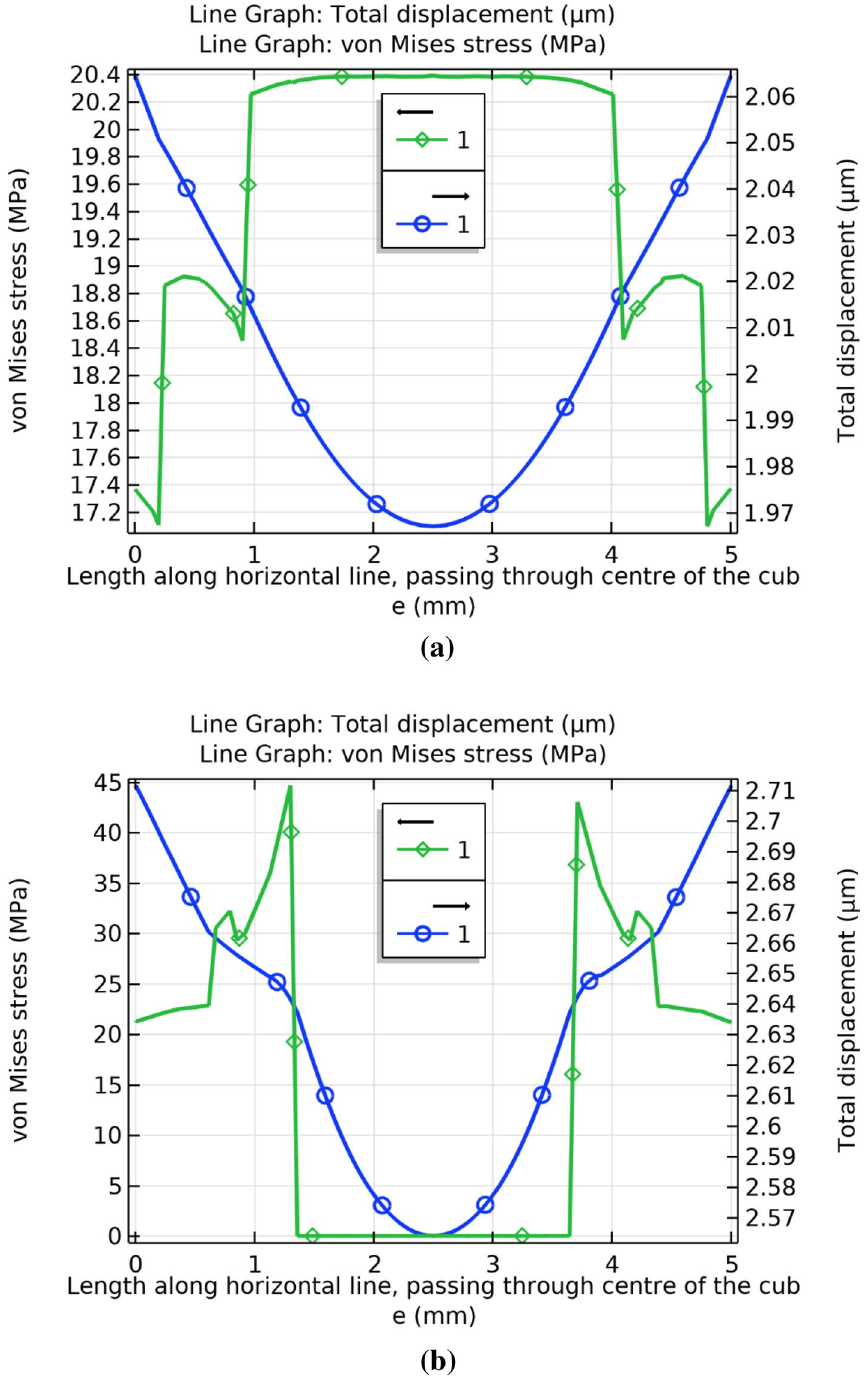
Figure 14. Von Mises stress and total displacement along center of ( a ) Concrete ( b ) Green CBC representative